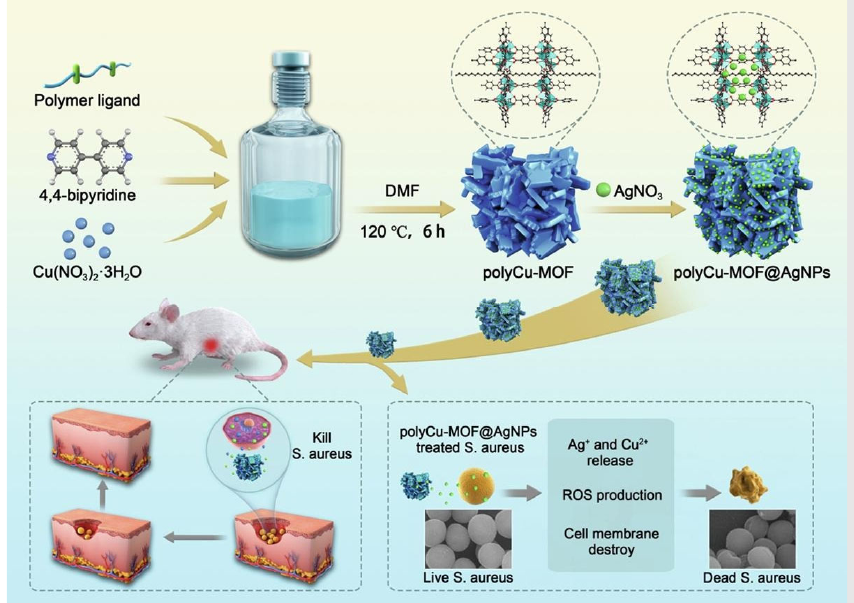
Figure 20. Scheme showing the synthesis of PolyCu-MOF@AgNPs and an illustration of the an- tibacterial properties of the product. The scheme shows in situ formation of loaded MOF/hybrid composites to create polyCu-MOF. The MOF composites are then post-synthetically treated with AgNO 3 to yield polyCu-MOF@AgNPs. In vivo experiments on mice show improved healing of bacteria-infected skin wounds and allow for the regeneration of collagen and the healing of damaged tissues. SEM images of in vitro treated S. aureus showing the change of morphology of dead S. aureus and listing the antimicrobial mechanisms as Ag + and Cu 2+ release, ROS production as well as cell membrane destruction. Reproduced with permission from [187].